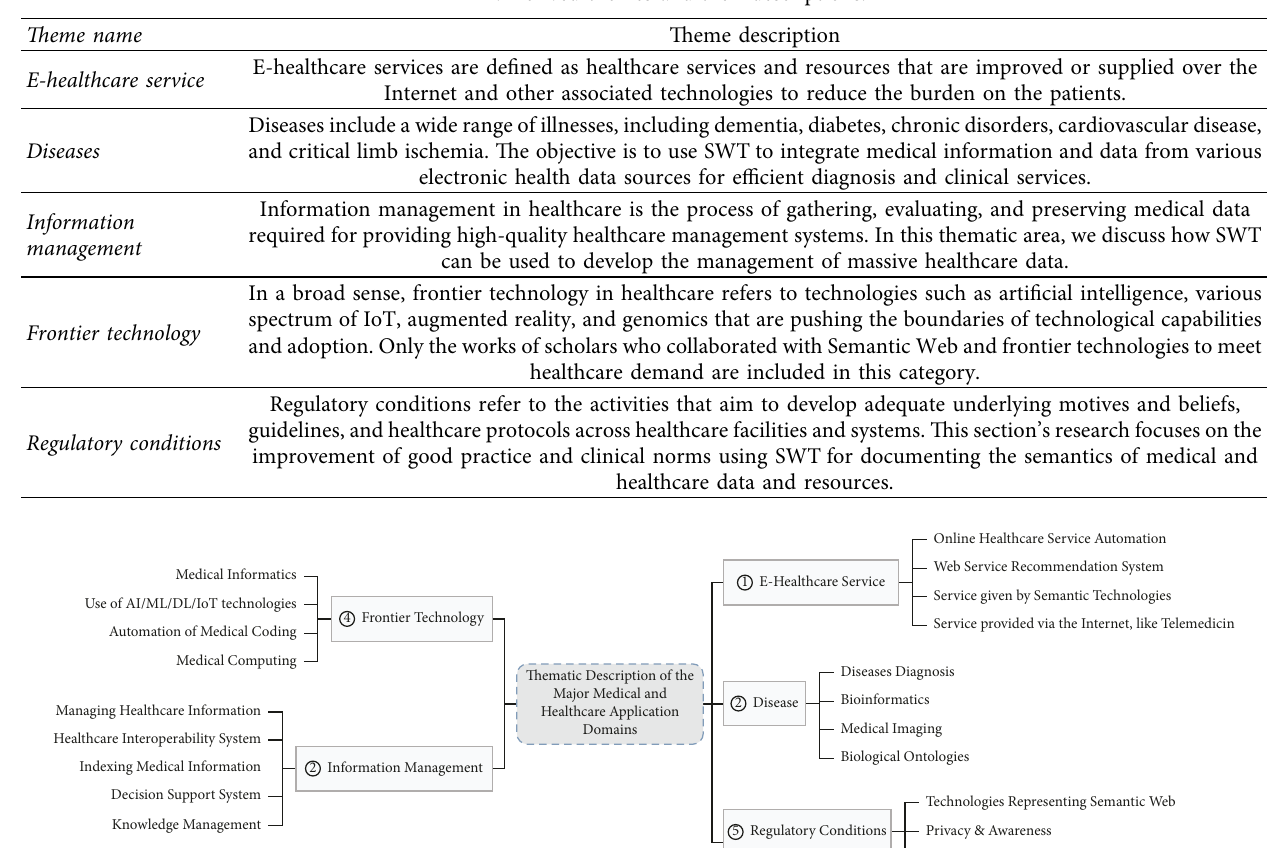
Table 2: Derived themes and their descriptions.